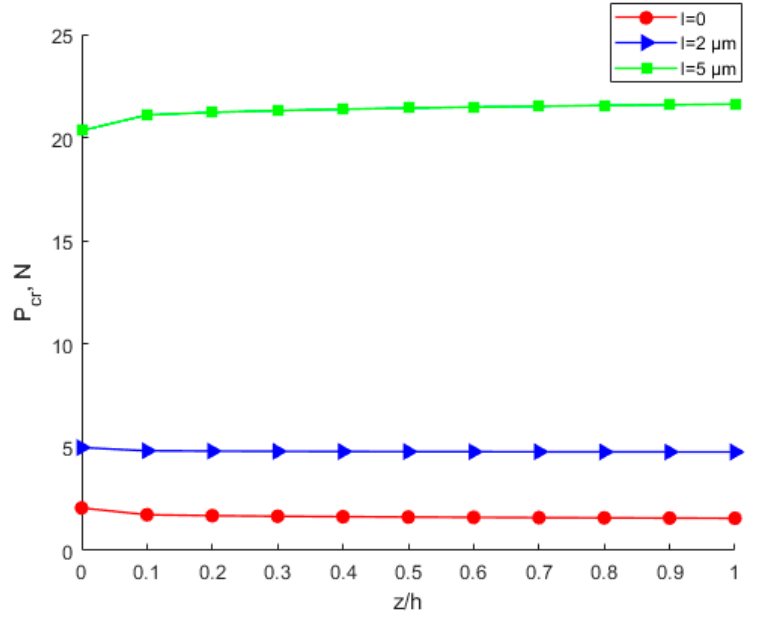
Figure 16. Influence of scale effect parameters on the critical buckling load when k = 0.2.